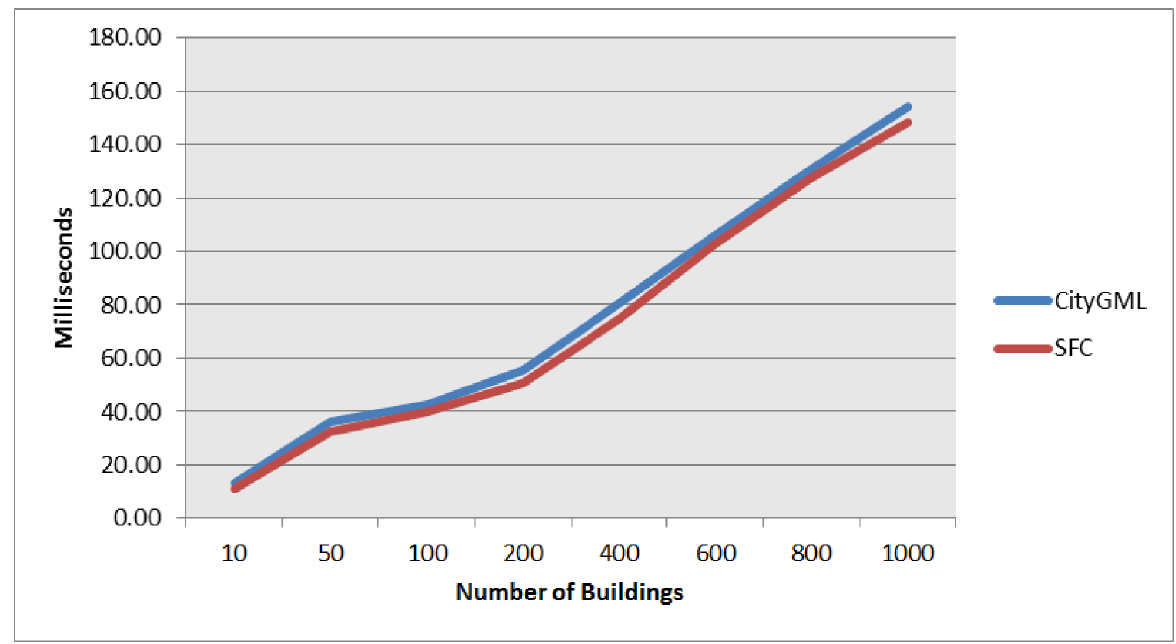
Figure 11: Data retrieval time for single object from target search